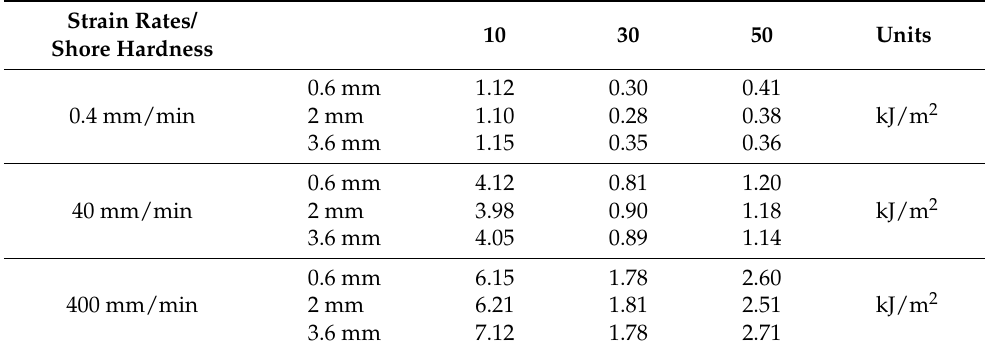
Table 1. Fracture toughness of Ecoflex at different strain rates and Shore hardness for all three thicknesses under pure shear